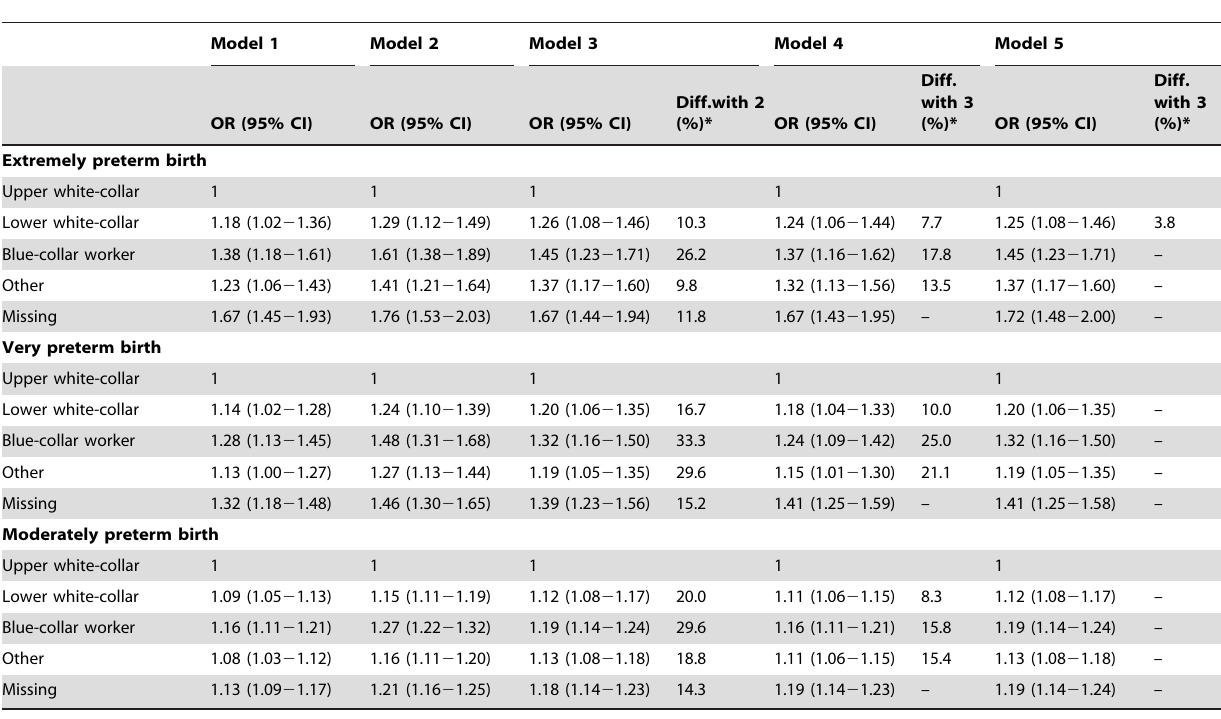
*(The contribution of each factor was measured by the percentage reduction in the odds ratio of socioeconomic status compared to Model 2 and 3 by using formula (OR Model 2/3– OR Model x)/(OR Model 2/3–1). Model 1=Adjusted by socioeconomic status. Model 2=Adjusted by socioeconomic status + age and parity. Model 3=Adjusted by Model 2 + smoking. Model 4=Adjusted by Model 3 + placental abruption + placenta previa + major congenital anomaly + anemia + stillbirth + SGA + fetal sex. Model 5=Adjusted by Model 3 + amniocentesis + chorionic villus biopsy + IVF. doi:10.1371/journal.pone.0060660.t003 PLOS ONE |